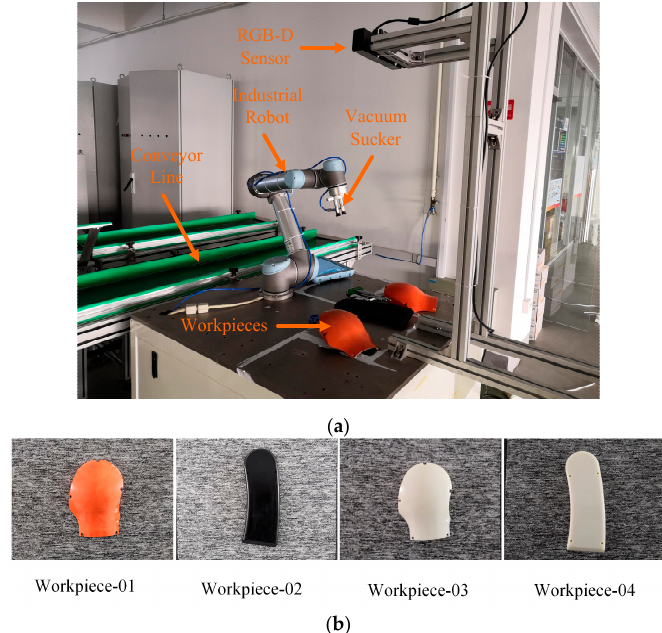
Figure 1. The experiment platform and workpiece types. ( a ) The workpiece grasping experiment platform, the vacuum sucker is used to grasp the workpiece from the platform onto the assembly line. ( b ) The four different types of workpieces that vary in shape and appearance.